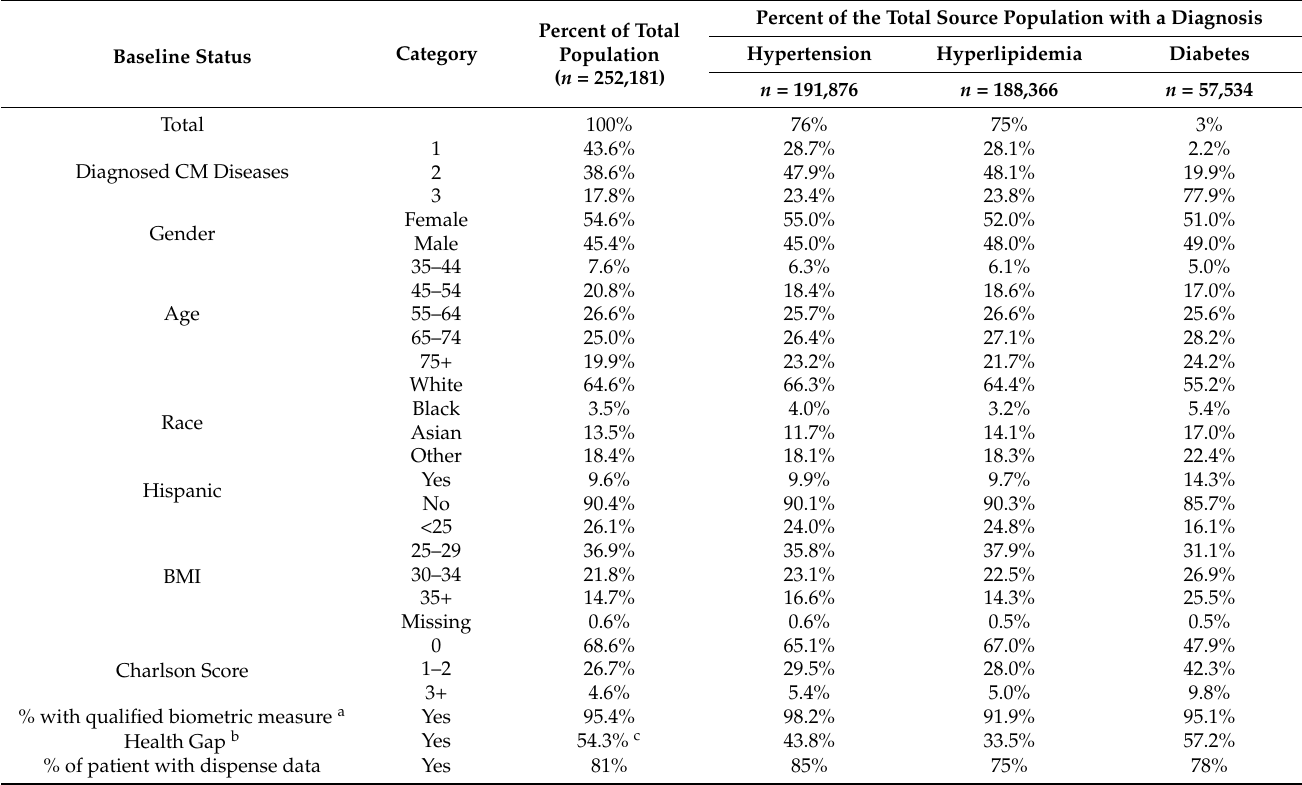
Table 2. Demographic and clinical characteristics of primary care patients 35+ years old diagnosed with hypertension, hyperlipidemia, or